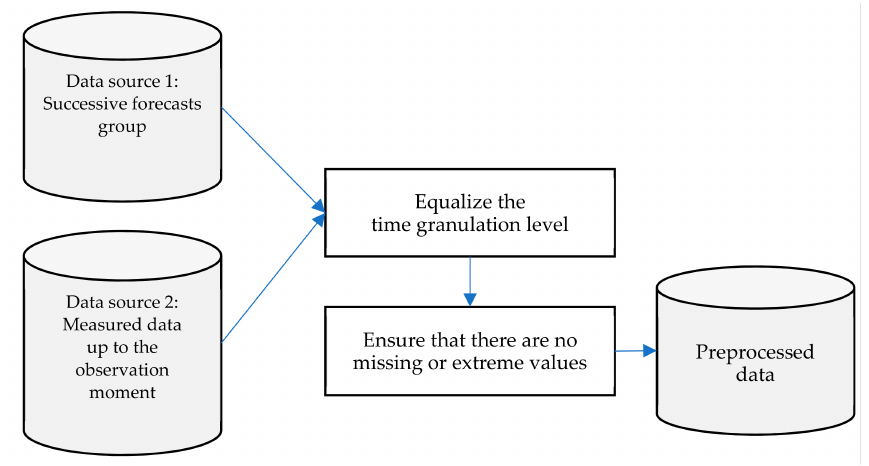
Figure 3. Data pre-processing